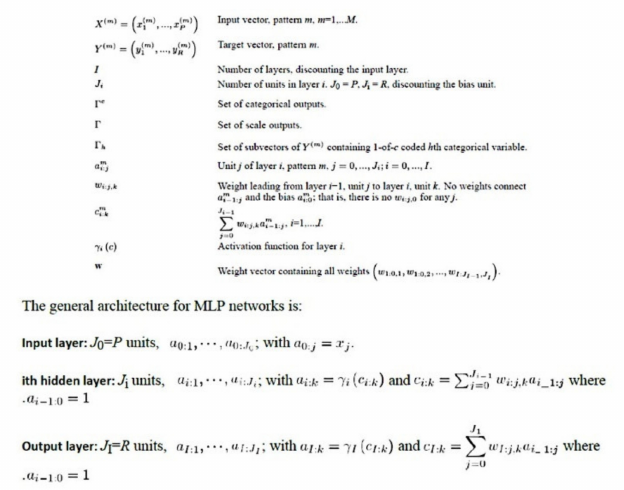
Figure 1. General architecture for multilayer perceptron (MLP) networks. A neural network is a set of non-linear data modeling tools consisting of input layers plus one or two hidden layers. The multilayer perceptron procedure is a feedforward architecture. In comparison to RBF, the MLP con find more complex relationships but it is slower to compute. The MLP network is a function of one or more predictors (also called inputs or independent variables) that minimizes the prediction error of one or more target variables (also called outputs)